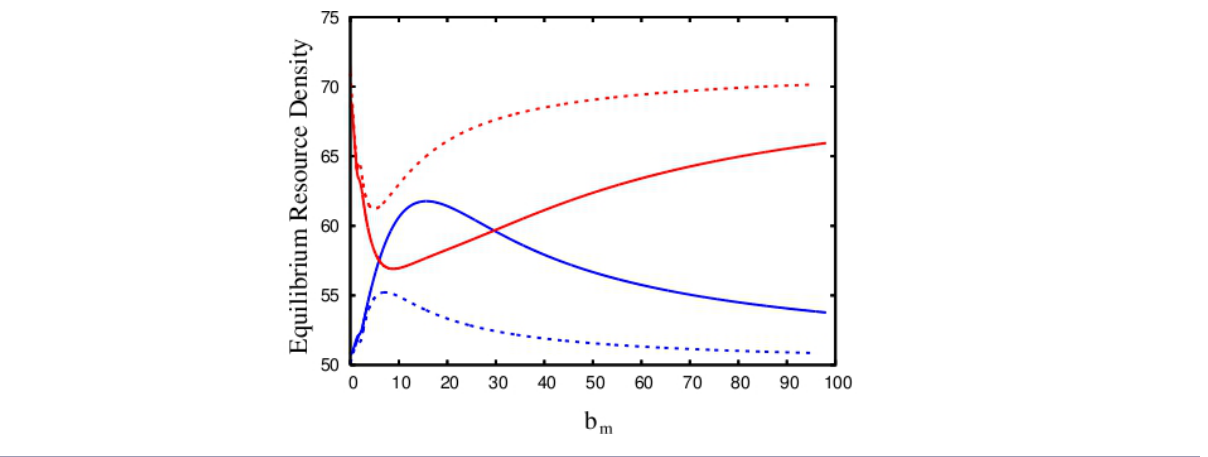
Fig. 4 . Equilibrium resource densities as a function of b (solid) and a = 20 m